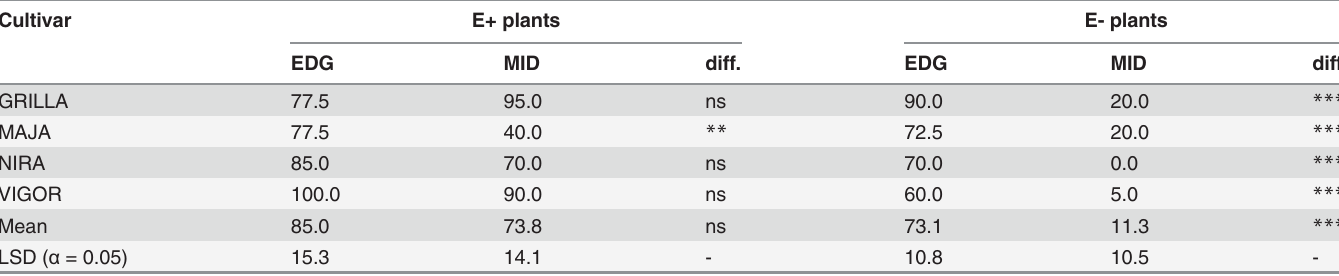
Table 2. Mean endophyte infection of perennial ryegrass cultivars (%) after 7 months of mowing. Cultivar E+ plants E- plants EDG MID diff. EDG MID diff. GRILLA 77.5 95.0 ns 90.0 20.0 *** MAJA 77.5 40.0 ** 72.5 20.0 *** NIRA 85.0 70.0 ns 70.0 0.0 *** VIGOR 100.0 90.0 ns 60.0 5.0 *** Mean 85.0 73.8 ns 73.1 11.3 *** LSD ( α = 0.05) 15.3 14.1 - 10.8 10.5 - Explanations: EDG – plants from the edge of plots, MID – plants from the middle of plots, diff. – signi fi cance of difference between EDG and MID plants: ns – not signi fi cant, signi fi cant with probability: ** — P > 95%. *** — P >